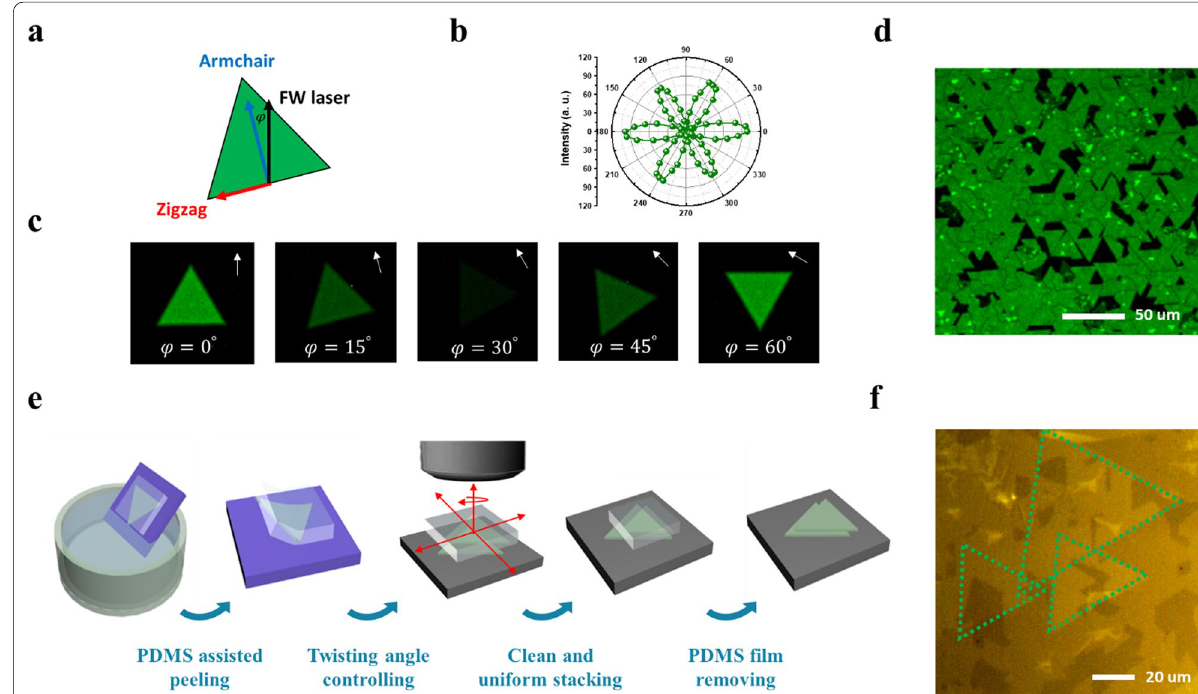
Fig. 2 Integrating the oriented TMD for scalable Moiré lattice with twisting control. a Schematic illustration of TMD with zigzag and armchair direction, while φ is defined as the angle between the polarization of incident FW laser and the armchair direction of the TMD. b Polar plot of polarization resolved SHG intensity. c, The SHG mapping images for monolayer MoS 2 grain with misaligned angles ( ϕ FW − D ) between 0° and 60°. d The SHG intensity mapping of epi‑TMD film. e Schematics illustration of clean water transfer technique with PDMS stamping. f OM images of the stacked